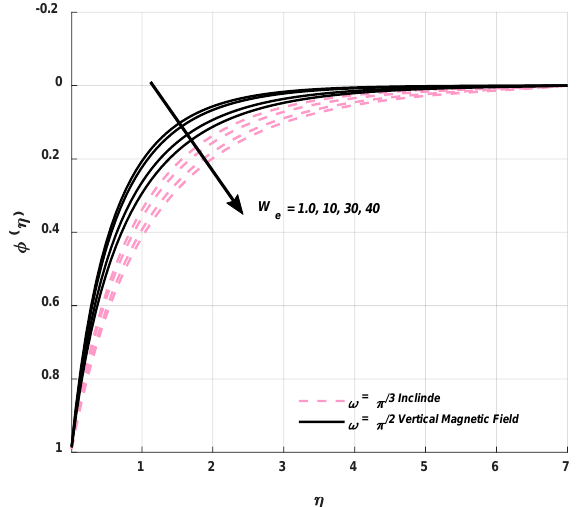
as shown in Figure 17. 𝜙𝜙(𝛾𝛾)